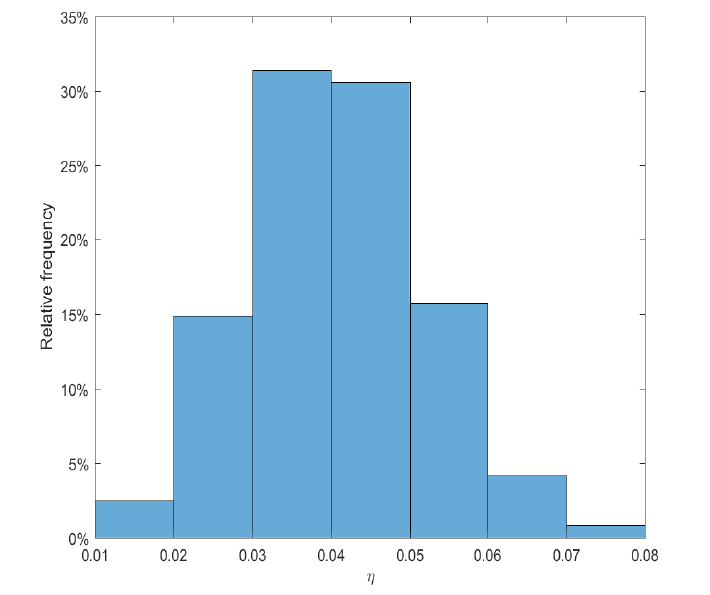
Figure 4. Relative frequency of consumption.